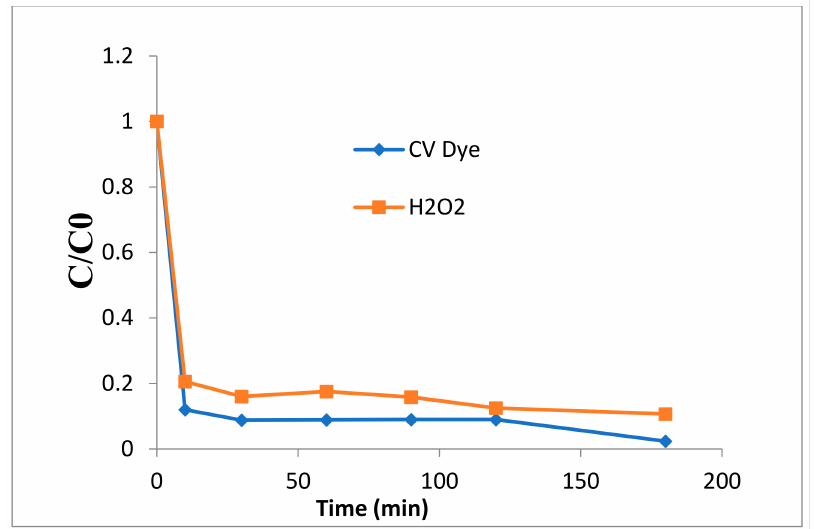
Figure 7. Degradation of CV dye and H 2 O 2 consumption during the photo-Fenton process under optimum conditions ((CV) = 10 mg/L, (H 2 O 2 ) = 30 mg/L catalyst concentration 1.0